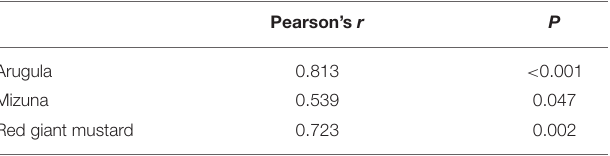
Statistical relations were determined with bivariate correlations (Pearson’s r), and a p < 0.05 was accepted as statistically significant. Correlations were made between soil and tissue Nitrate-N concentrations for each individual plant species.